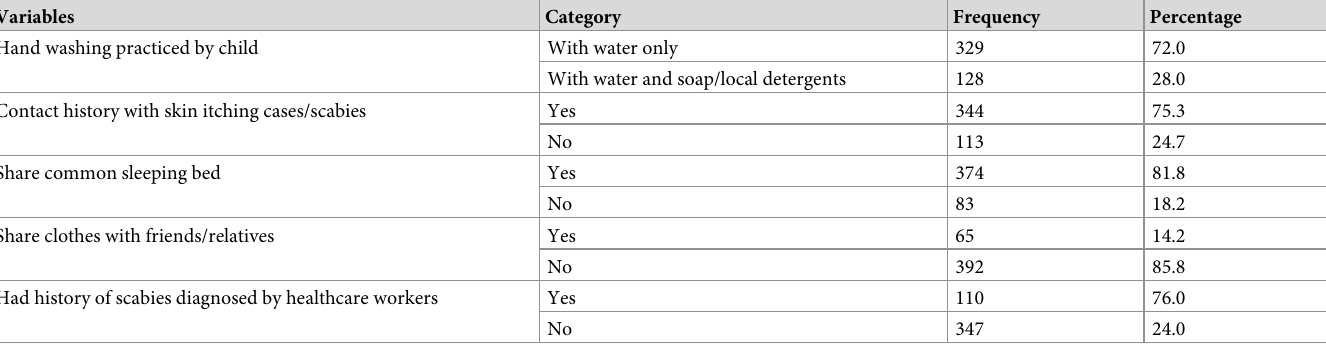
Table 3. Hygiene practice of children aged 5–14 years, Meta Robi District, Ethiopia, 2020.